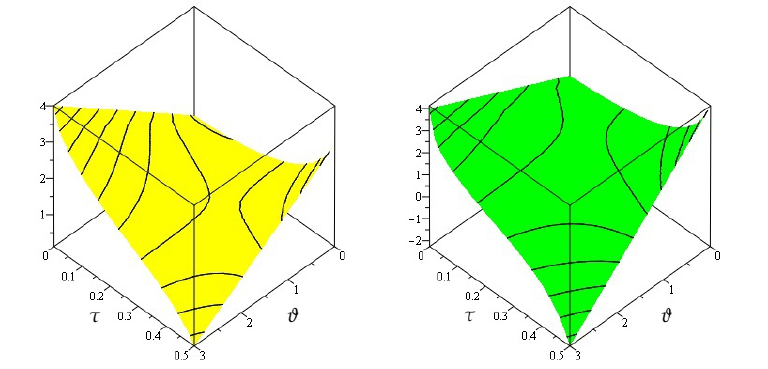
Figure 13. Exact and analytical solution of ν ( ϑ , ζ , z , τ ) at (cid:36) = 1 and 0.8 of Example 4.